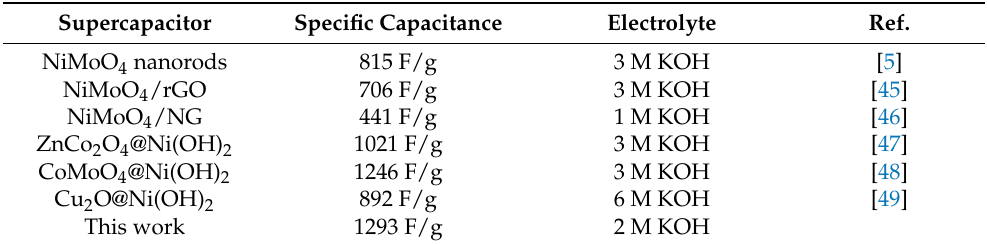
Figure 6. ( a ) CV curves of the NF, NMO, NMH − 1, NMH − 2, and NMH − 3 at 5 mV/s. ( b ) CV curves of the NMH − 2 at 5–50 mV/s. ( c ) GCD curves of the NMH − 2 at 1–10 A/g. ( d ) Specific capacitances of the NMO, NMH − 1, NMH − 2, and NMH − 3 at 1–10 A/g. ( e ) Nyquist plots of the NF, NMO, NMH − 1, NMH − 2, and NMH − 3. ( f ) Cyclic performance of the NMH − 2 at 10 A/g. Table 2. Comparison of specific capacitances of NMH − 2 electrode materials with reported related electrodes at 1 A/g .